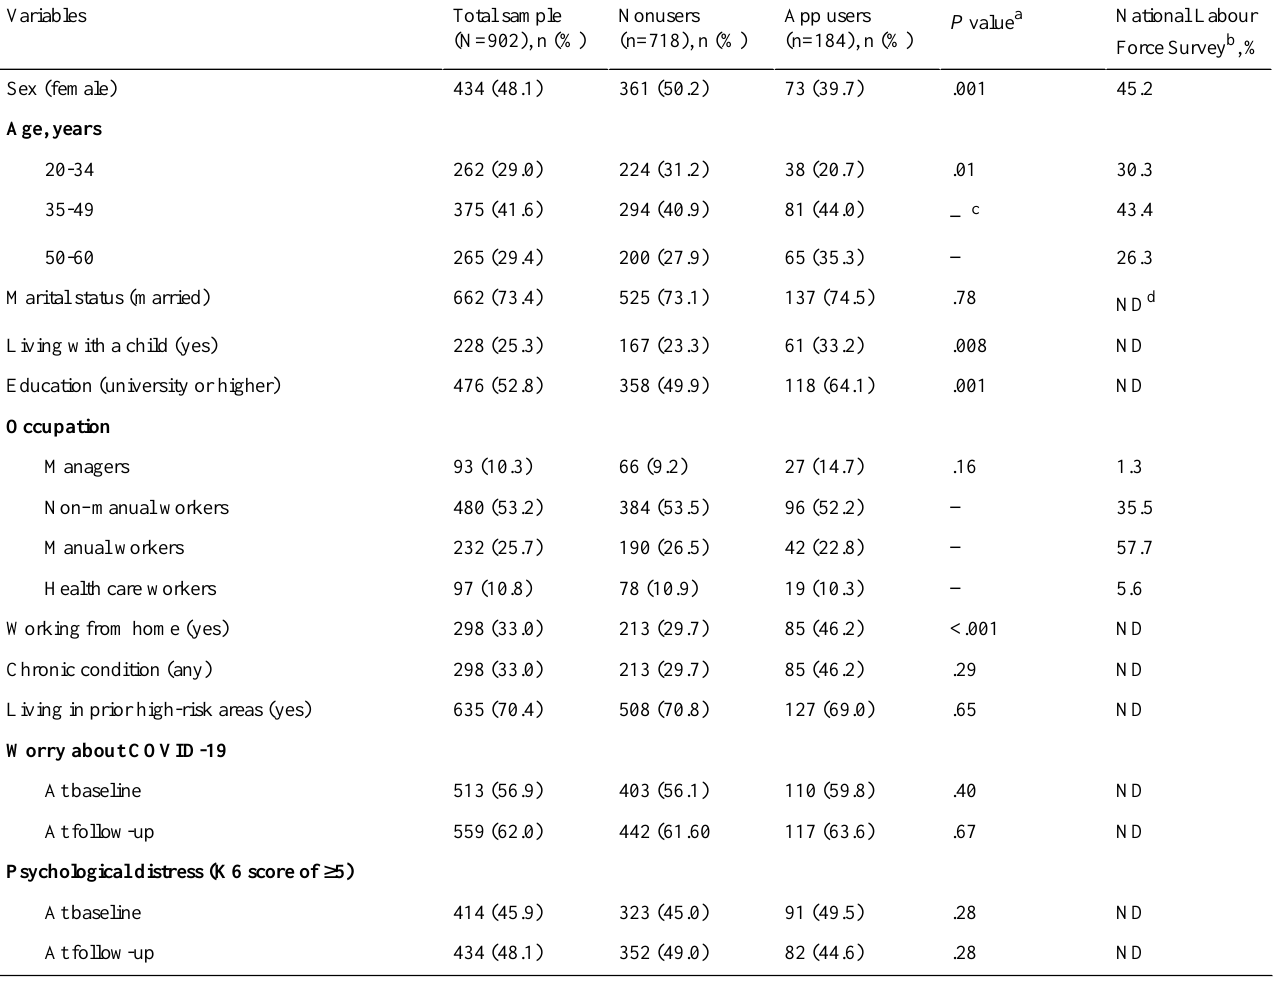
Table 1. Demographic characteristics at baseline and psychological variables at baseline and follow-up among respondents who used or did not use the COVID-19 COntact COnfirming Application (COCOA) at